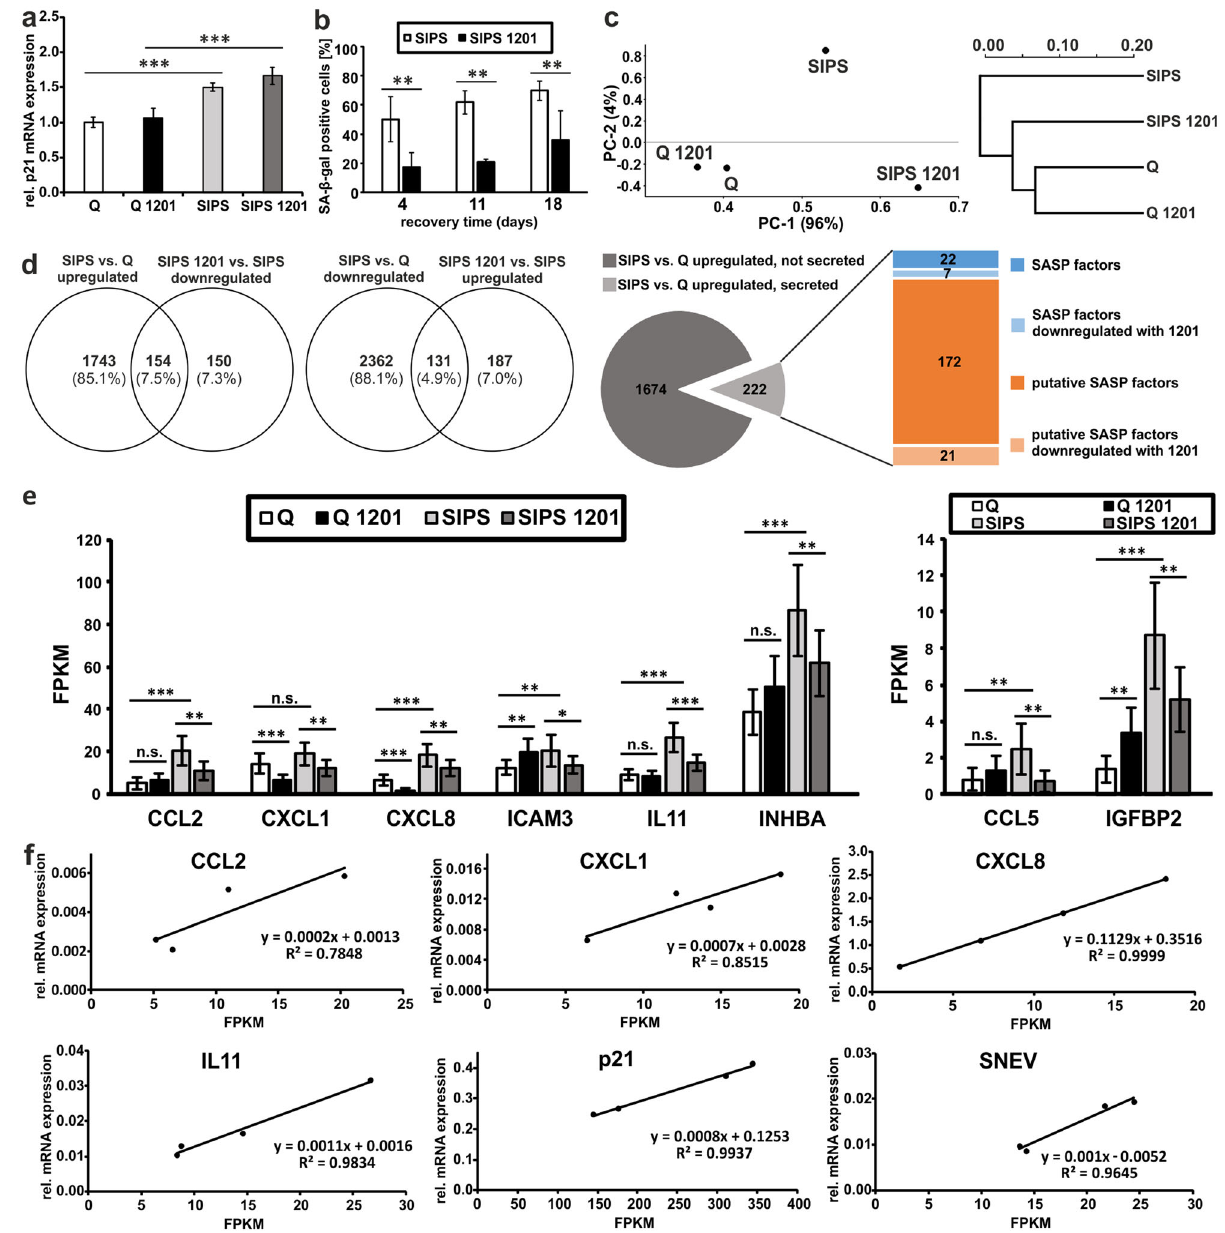
Fig. 4 1201 attenuates the senescent phenotype in SIPS HDFs. a SIPS was induced by chronic oxidative stress and HDFs were subsequently cultivated for 4 days in growth medium supplemented with 1201. RT-qPCR of p21 (expression levels of untreated quiescent control cells (Q) were set to 1). b SA- β -gal staining of SIPS HDFs after 4, 11 and 18 days of cultivation in growth medium supplemented with 1201. Cells were treated as described in a and RNA-Seq was performed. c PCA analysis and hierarchical clustering. d Venn diagrams identifying the genes which are differential expressed in SIPS compared to Q and are regulated contrariwise by treatment of SIPS with 1201. The pie chart illustrates the identi fi ed SASP factors and their response to the treatment with 1201. e Transcript levels of all upregulated SASP factors which were regulated contrariwise by treatment with 1201, displayed as Fragments Per Kilobase of transcript per Million mapped reads (FPKM). Error bars indicate con fi dence intervals (95%). f Six genes were quanti fi ed with RT-qPCR from the same RNA samples which were used for RNA-Seq and correlated with the transcript levels derived from RNA-Seq. From a to f , data represent the average of three experiments. Statistical signi fi cance for the treatments in a ( p < 0.001 for SIPS treatment and p = 0.088 for 1201 treatment) and b ( p < 0.001) were calculated with a two-way ANOVA followed by a Bonferroni post hoc test. The p -values of e were corrected with the false discovery rate for multiple comparisons using the Benjamini – Hochberg Site-matched papillary and reticular HDFs were isolated from the dermis as described 37 and their identity was con fi rmed by measurement of the expression levels of three papillary and three reticular mRNA markers. The isolated from a skin biopsy, which was purchased from Biopredic site-matched papillary and reticular HDFs were isolated from surplus tissue International (Saint-Grégoire, France). The Ethic Committee of the Medical University of Vienna (1149/2011) approved the collection of the biopsy used for the isolation of keratinocytes for the HSEs containing SIPS HDFs.